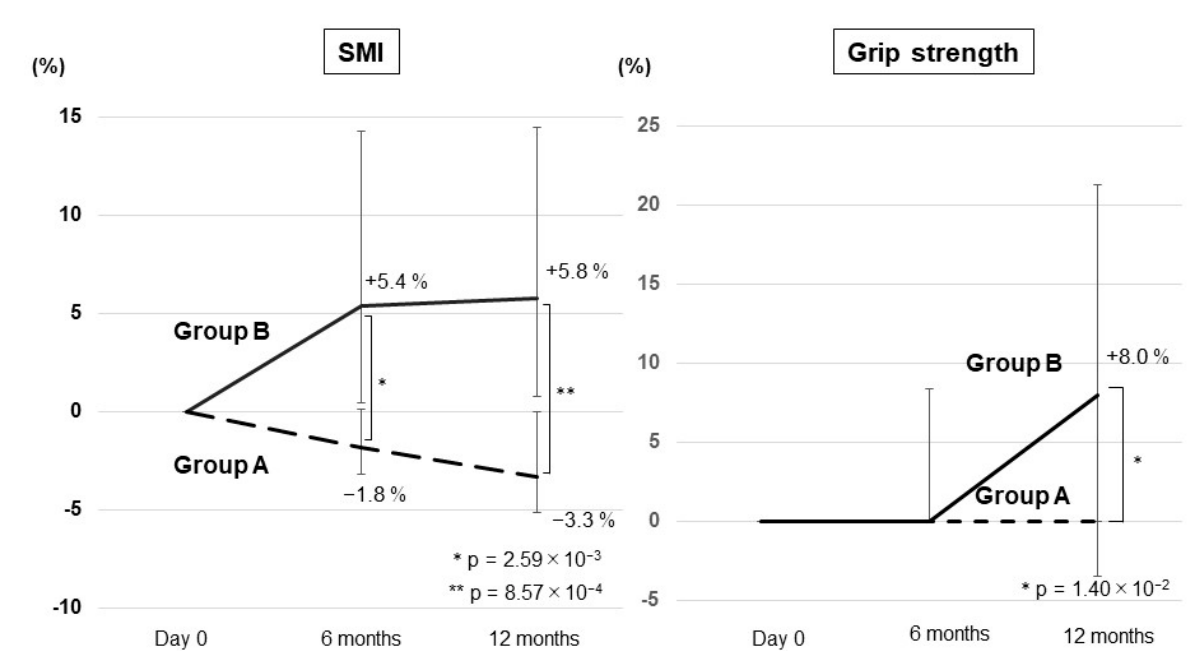
Figure 5. Time-course of the change rates in the skeletal muscle mass index (SMI) and grip strength in the untreated (Group A) and vitamin D-treated (Group B) patients. The error bar represents the quartile.